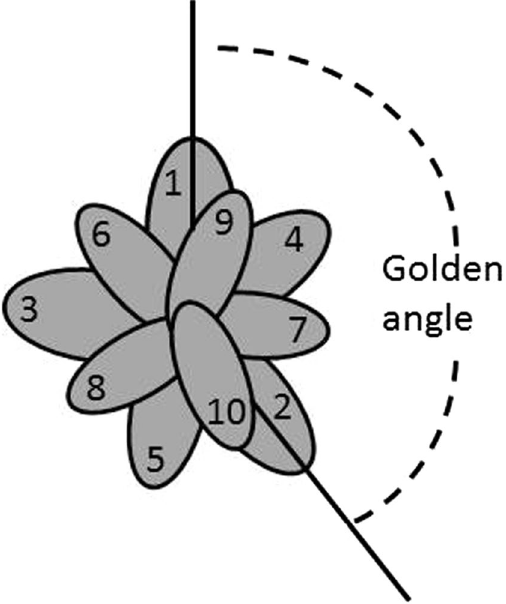
Figure 2. Schematic representation of plant leaves positioned according to the Golden Ratio, seen from above. The two solid lines make the Golden angle of 360°(1 − 1/ Φ ) ≅ ° 137, 5 . This arrangement implies that the overlap between leaves (numbered in ascending order) is minimized, since the GR can be approximated poorly by rational numbers t / n , where t and n are the number of turns and leaves, respectively. Analogously, a division of the “cake” in the UG following the GR can only be approximated poorly by ratios of small